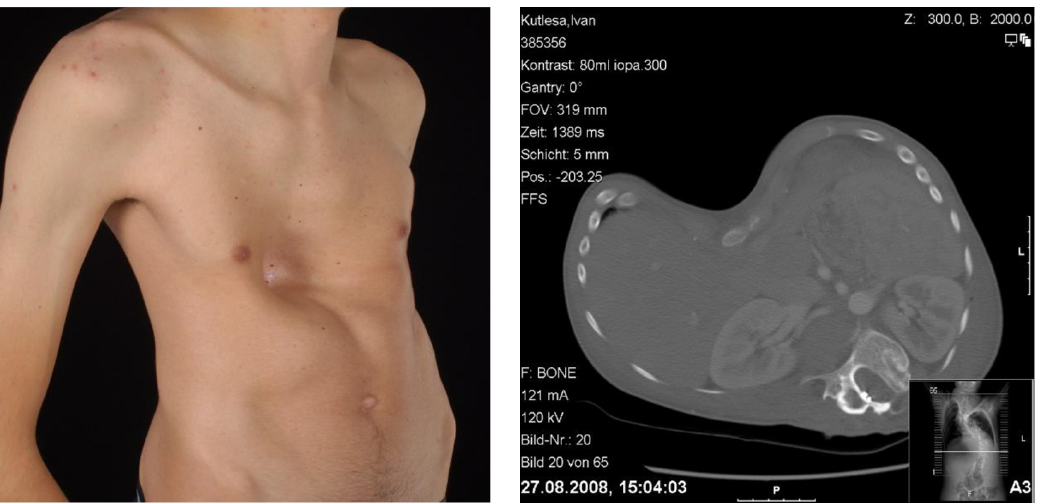
Figure 1. Clinical aspect and ct-scan of a 18 years old male patient with severe PE and combined severe scoliosis.